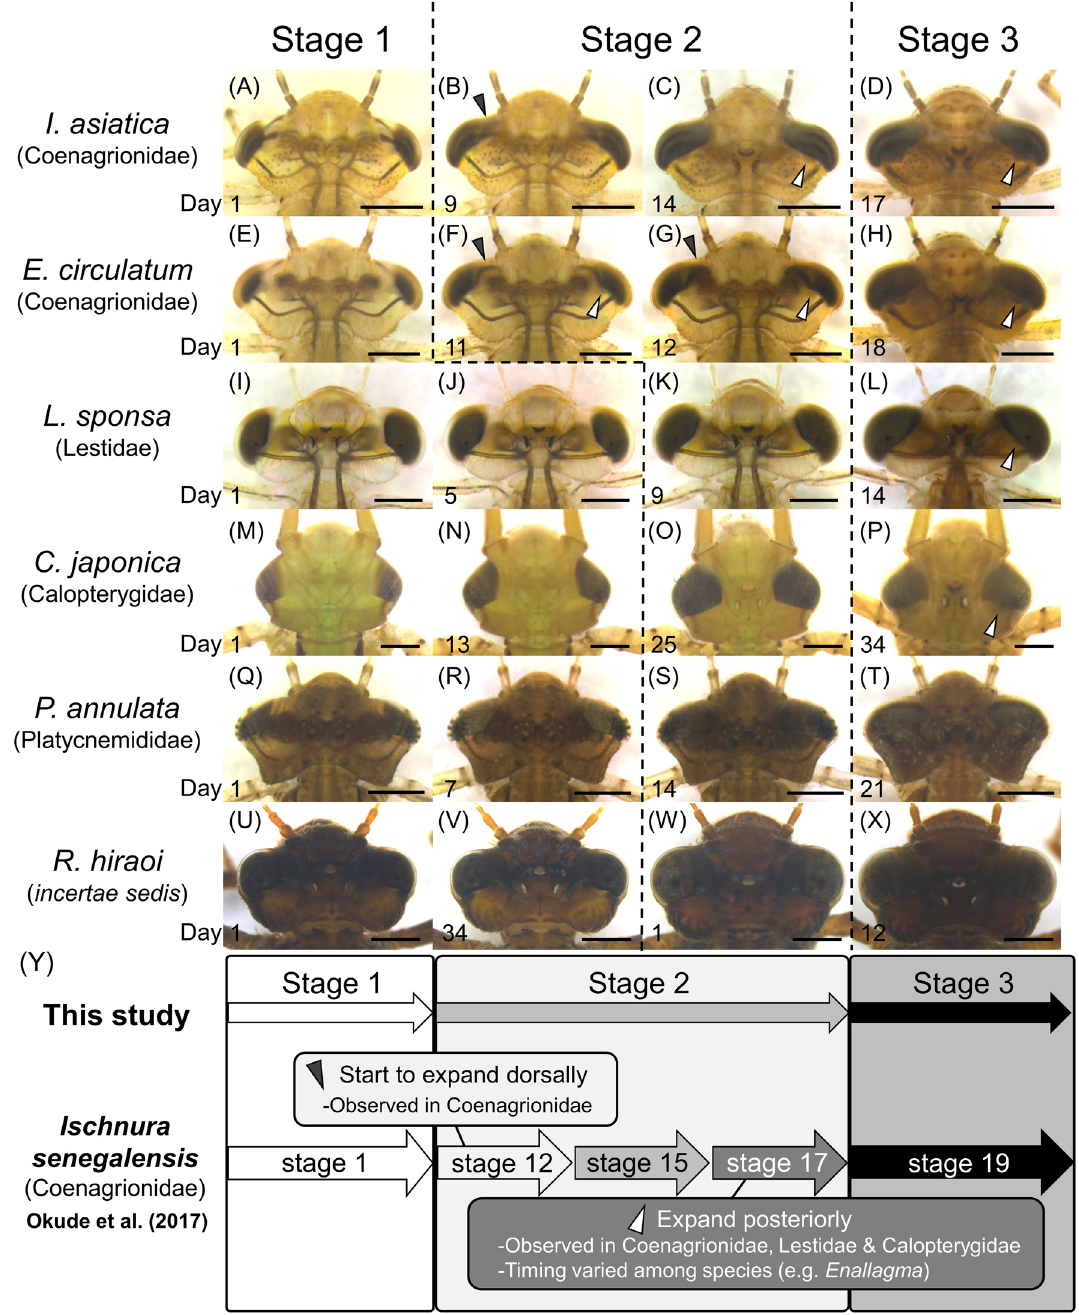
Figure 4. Morphological changes during F−0 instar observed in the compound eyes of damselfly (Zygoptera) larvae. ( A – X ) Dorsal views of the heads. All scale bars show 1 mm. Species and family names are provided on the left side. The number shown on the lower left of each image indicates the number of days after ecdysis to F−0 instar ( A – T ) and after starting of photographing ( U – X ). Black arrowheads indicate the dorsal expansion of the compound eyes, whereas white arrowheads indicate the posterior expansion of the compound eyes. ( A , E , I , M , Q ) The first day of stage 1. ( B , F , K , O , S ) The first day of stage 2. ( C ) The first day of stage 17 12 in which posterior expansion begin. ( D , H , L , P , T ) The first day of stage 3. ( U ) The first day of photographing in individual No.5–1 (stage 1). ( V ) The 34th day of the photographing in individual No. 5–1 (stage 1). This individual No. 5–1 died before entering stage 2. ( W ) The first day of the photographing in individual No. 5–2 (early stage 2). ( X ) The first day of stage 3 in individual No. 5–2. ( Y ) Schematic diagrams of the comparison of the developmental stages during F−0 larval instar defined in this study and those proposed by Okude et al. 12